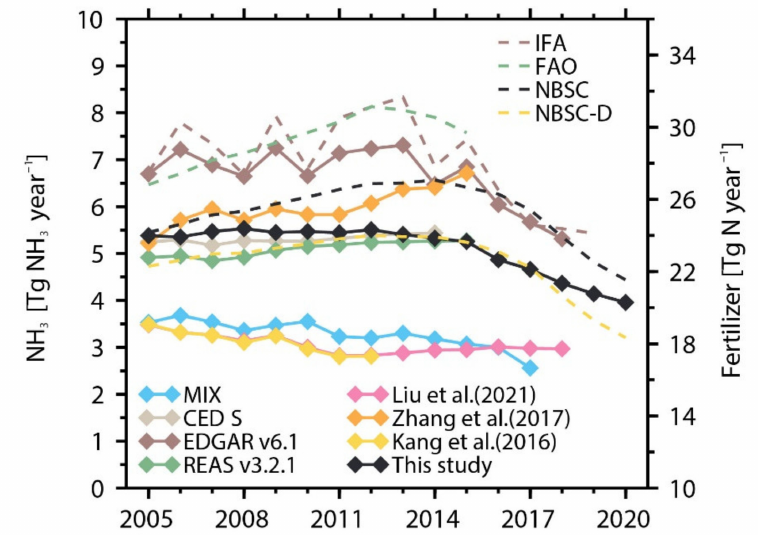
Figure 8. Inter-annual variations of synthetic nitrogen fertilizer application (right y -axis; dashed lines) and NH 3 emissions from fertilizer application (left y -axis; solid lines) from different inventories in